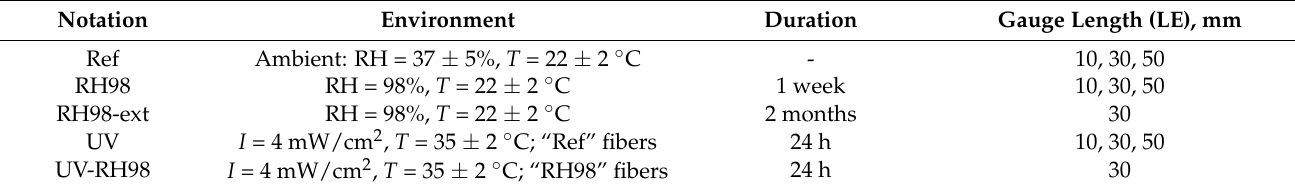
Table 1. Details on fiber conditioning under different